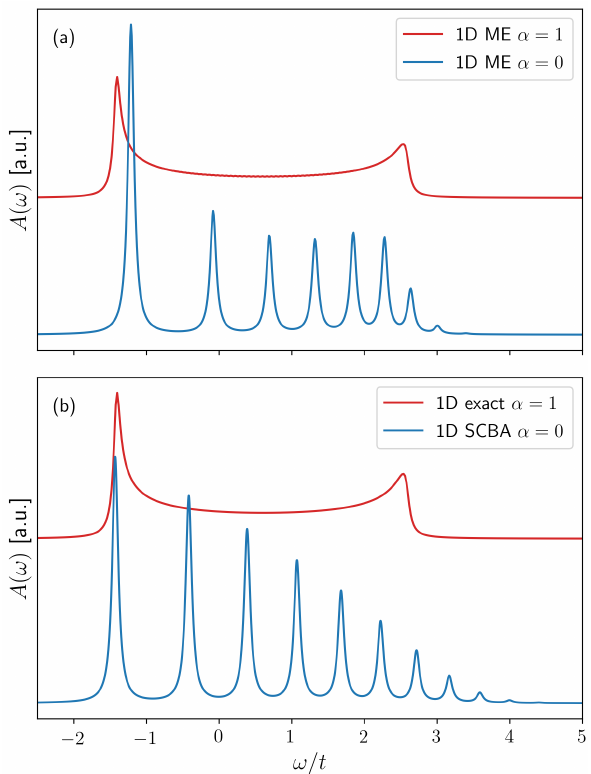
Figure 2: Spectral function A ( ω ) of a single hole in the 1D t – J and without ( α = 0) magnon-magnon interactions correctly included in the model calculated using: (a) the ME method, (b) the analytically exact or SCBA approach. Parameters: J = 0.4 t , broadening δ = 0.05 t ; the bound state at the low-energy onset of A ( ω ) splits off from the continuum at larger J / t (lower δ ). Note that in the SCBA calculations for α = 0 ( α = 1) constraints C1 , C2 are excluded (included),